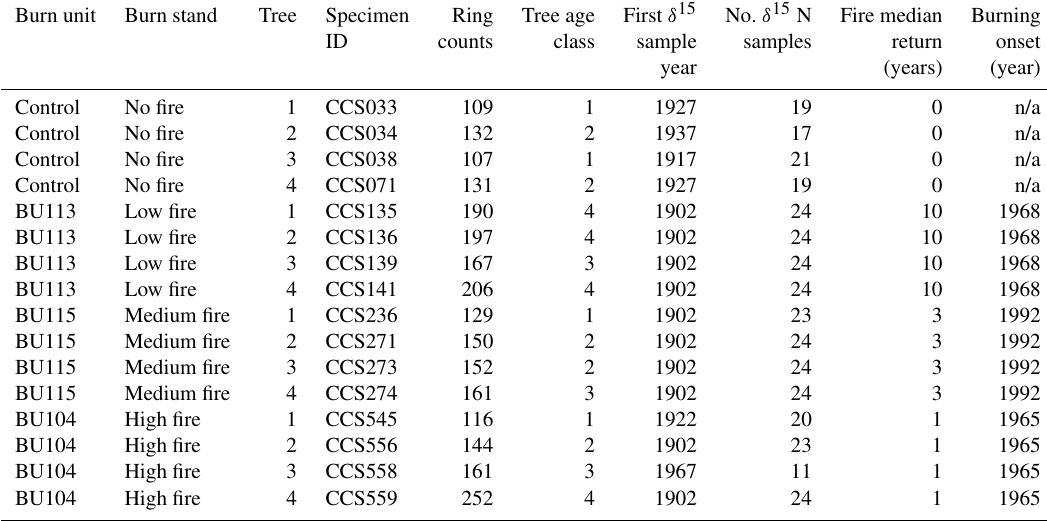
Table 1. List of the trees sampled, ring counts, first sample year for δ 15 N, number of δ 15 N samples, fire median return, and the first year of prescribed burning. Ring count is the total number of years for each core and does not represent specific tree age, as pith was not present for all cores. Trees in age class 1 contain < 129 rings, trees in age class 2 contain 130–159 rings, trees in age class 3 contain 160–189 rings, and trees in age class 4 contain > 190 rings.